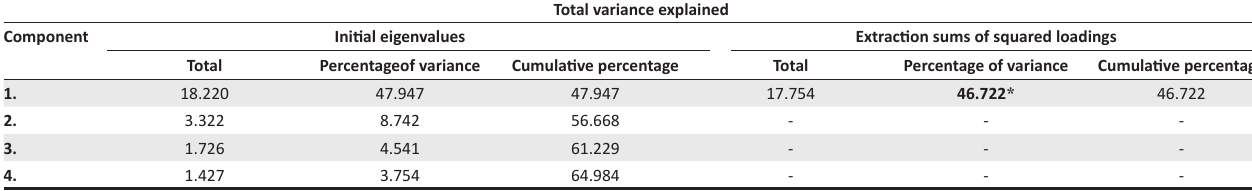
TABLE 2: The result of common method